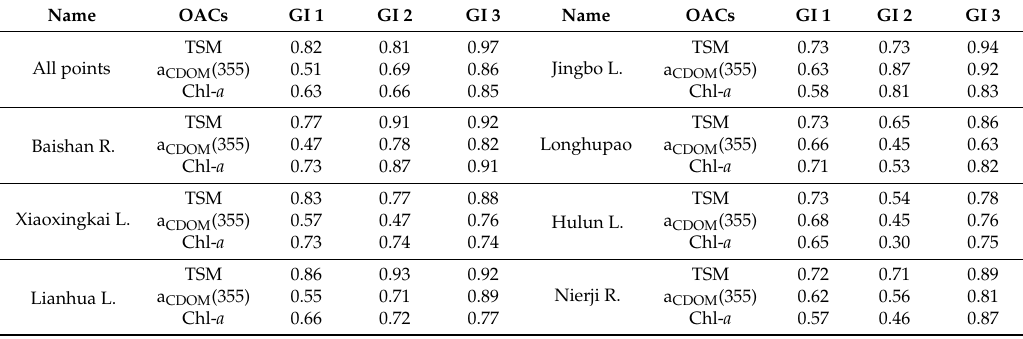
Table 2. GIs between the OACs and K d (PAR) of all the sample points and of lakes whose number of sampling points were greater than 10. The bigger the GI the larger the influence of OACs on K d